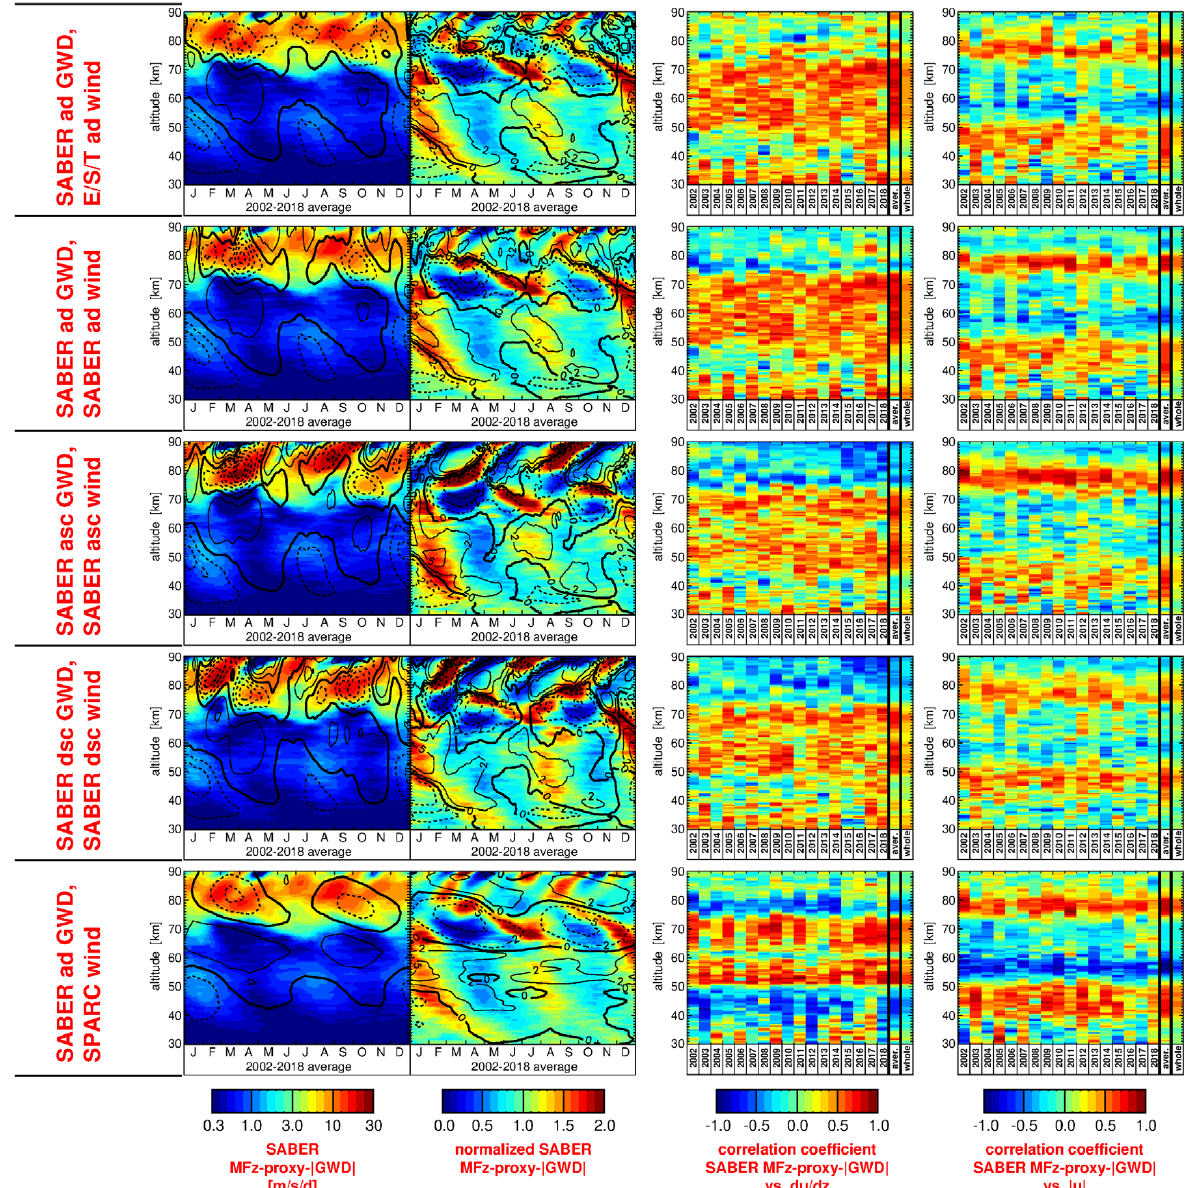
Figure 8. Left column: the SABER MFz-proxy- | GWD | (a proxy for absolute gravity wave drag) averaged over 10 ◦ S–10 ◦ N and the years 2002–2018, overlaid with zonal wind contour lines of different zonal wind data sets averaged over the same latitudes and period. Second column: same as left column but for normalized SABER MFz-proxy- | GWD | overlaid with contour lines of zonal wind vertical gradients. Third column: temporal correlations between SABER MFz-proxy- | GWD | and zonal wind vertical gradients, separately for each year, for the multi-year averages, and for the whole time series. Right column: same as third column but for the correlation between SABER MFz-proxy- | GWD | and zonal wind absolute values. The different rows are (from top to bottom) for (1) the merged ERA-Interim, SABER and TIDI data set as described in Sect. 4.2.3 averaged over ascending and descending orbit legs; (2) ERA-Interim and SABER winds merged, similarly as for MLS in Sect. 4.2.2, averaged over ascending and descending orbit legs (i.e., SABER geostrophic winds are used also above 75km); (3) same as (2) but only for ascending orbit legs; (4) same as (2) but only for descending orbit legs; and (5) SPARC climatology winds (same wind used for each year). For zonal winds, contour line increment is 20ms − 1 . The zero wind line is highlighted in bold solid contour lines, and westward (eastward) winds are indicated by dashed (solid) contour